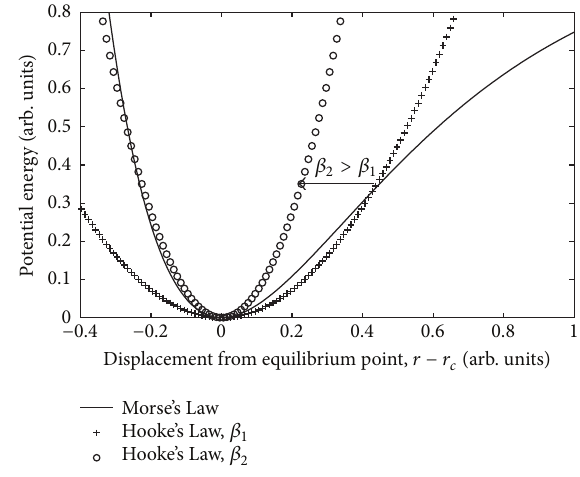
Figure 8: Potential energy curves plotted with Morse’s and Hooke’s Laws. A possible overtone transition from a lower to higher 𝛽 mode is shown by the